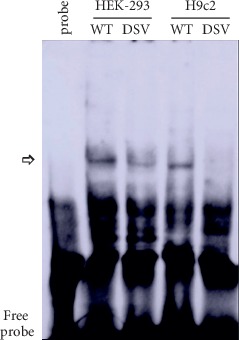
EMSA of biotin-labeled oligonucleotides containing the variant (g.106326168_70delTCT). Wild-type and variant oligonucleotides (30 bp) were designed and labeled with biotin. EMSA was conducted with biotinylated oligonucleotides and the nuclear extracts from HEK-293 and H9c2 cells. The free probe was marked with an arrow at the bottom. The affected binding for the transcription factor was marked with an open arrow.